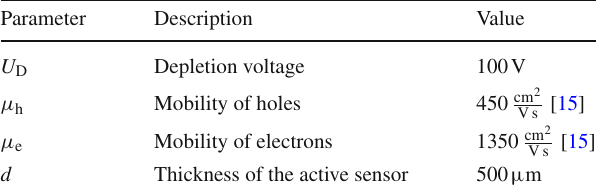
Table 1 Overview of silicon sensor related values used for calculating the drift times Parameter